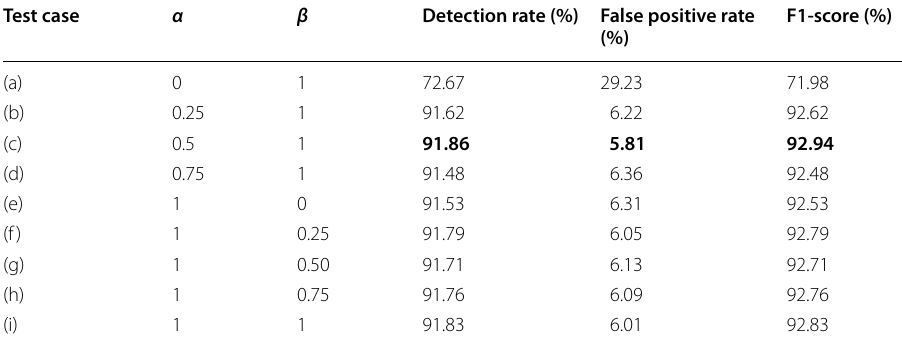
Bold indicates better results